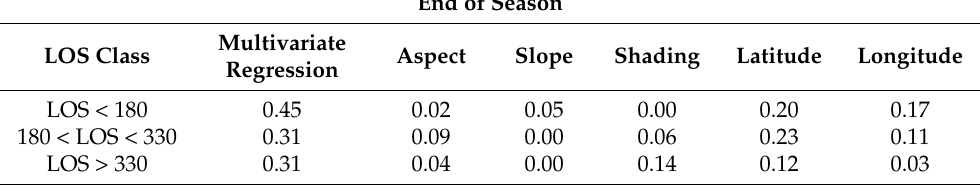
Table 4. Variance explained by the linear regression of individual variables against the three metrics in the GAR for different LOS (length of season) classes. Elevation is removed by subtracting the average in each 5-m elevation interval, and a linear regression is applied to the residuals. Each cell reports the R 2 . Length of Season Multivariate Aspect Slope Shading Latitude Longitude LOS Class Regression